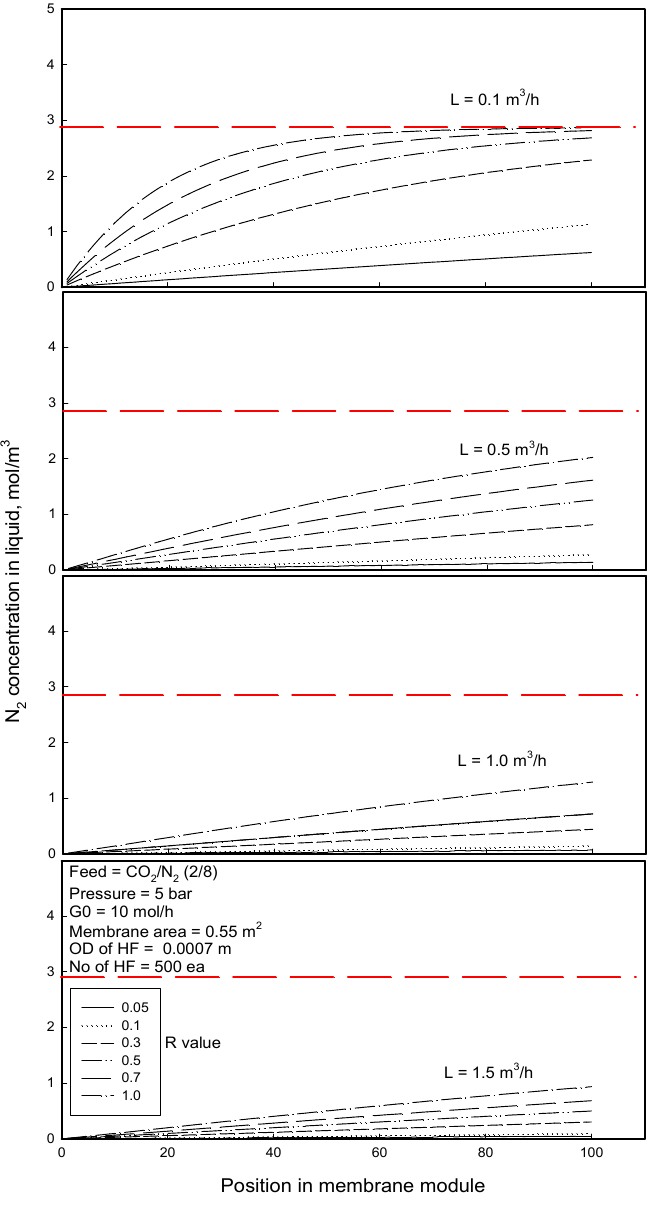
Figure 11. N 2 concentration in liquid stream with the position of module length in gassing process for the separation of CO 2 /N 2 mixture: red broken line = x E , equilibrium N 2 concentration in the liquid stream. At a given liquid flow rate, feed gas flow rate along the module length is reduced as much as the sum of the permeation rates of gas components through the membrane (Fig- ure 12). Decreasing the gas flow rate is more remarkable for the membrane with higher R- value due to higher permeation rate of gas component. When the liquid flows faster in the module, the liquid allows more gas molecules to be dissolved in it, expediting to permeate them especially through membrane with larger R-value while reducing feed gas flow rate as much. It is interesting to find that the feed gas flow rate in the module with high R- value decreases and then levels off with the position of module length when the liquid flow rate is low enough (0.1 m 3 /h). However, the feed gas flow rate keeps on decreasing with the position of module length when water flow rate is 0.5 m 3 /h or higher, decreasing more significantly as the liquid flow rate increases. It can be explained by the dissolved gas amount with liquid amount as mentioned in Figure 11. When liquid flow is slow enough, the dissolution of gas permeant to the liquid tends to be easily saturated before